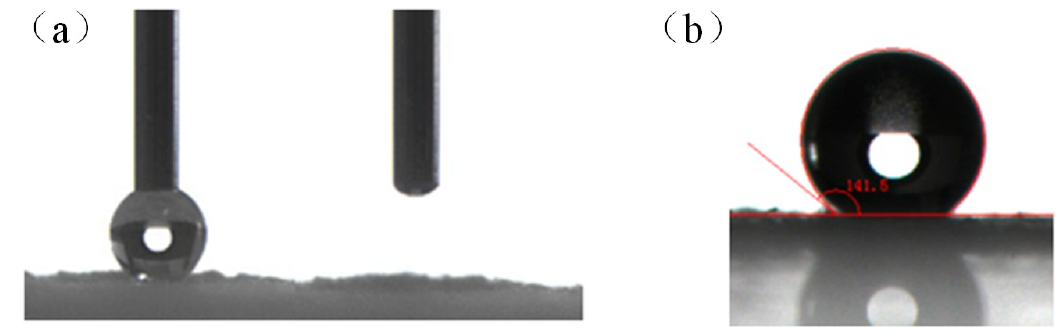
Figure 1. The WCA of unmodified MCC ( a ), the WCA of modified MCC ( b ).